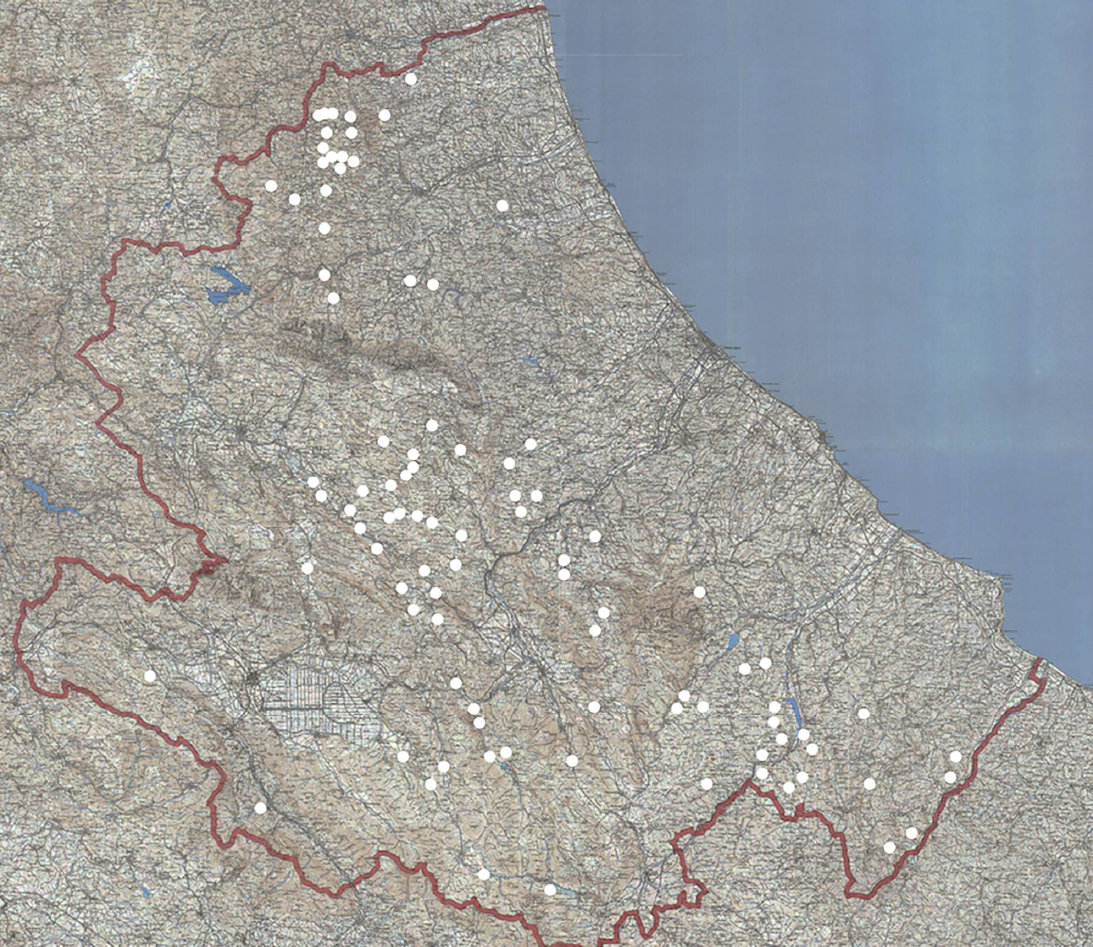
Figure 1. Map of 58 municipalities with less than 500 inhabitants in